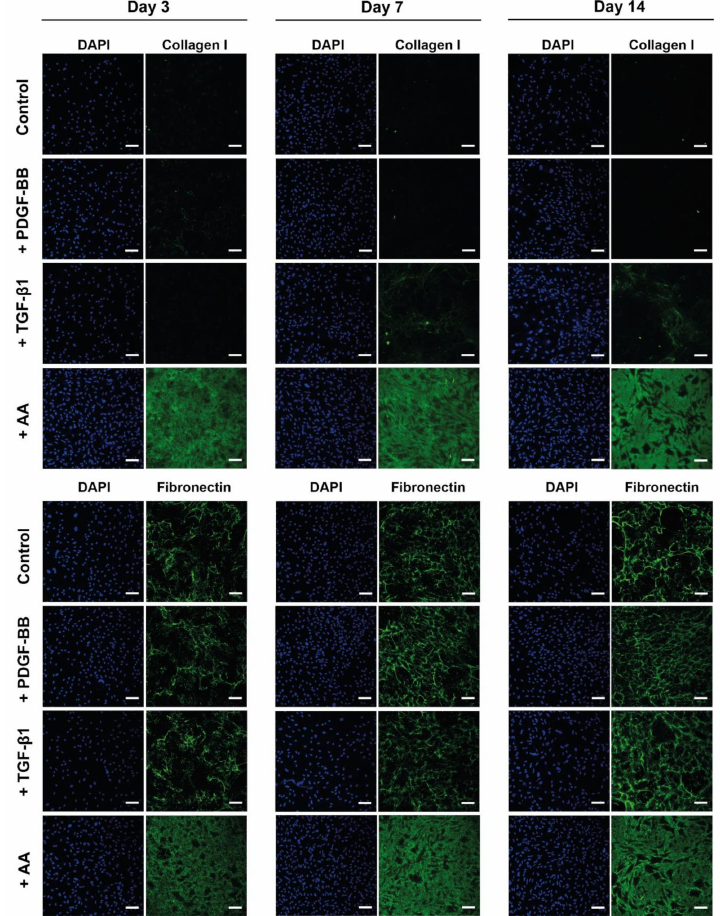
Figure 4. Extracellular matrix deposition by tenocytes stimulated with PDGF-BB, AA or TGF- β 1. Representative CLSM images of collagen I or fibronectin staining (green) and cell nuclei DAPI staining (blue) of rabbit tenocytes cultured in vitro in 2D, treated with PDGF-BB (50 ng / mL), TGF- β 1 (10 ng / mL), AA (50 µ g / mL) or untreated (control) on day 3, 7 and 14. For additional data of the same experiment performed with tenocytes isolated from two other animals and for quantification of the fibronectin deposition under the di ff erent treatments, we refer to the figures in the supporting information. Scale bars: 100 µ